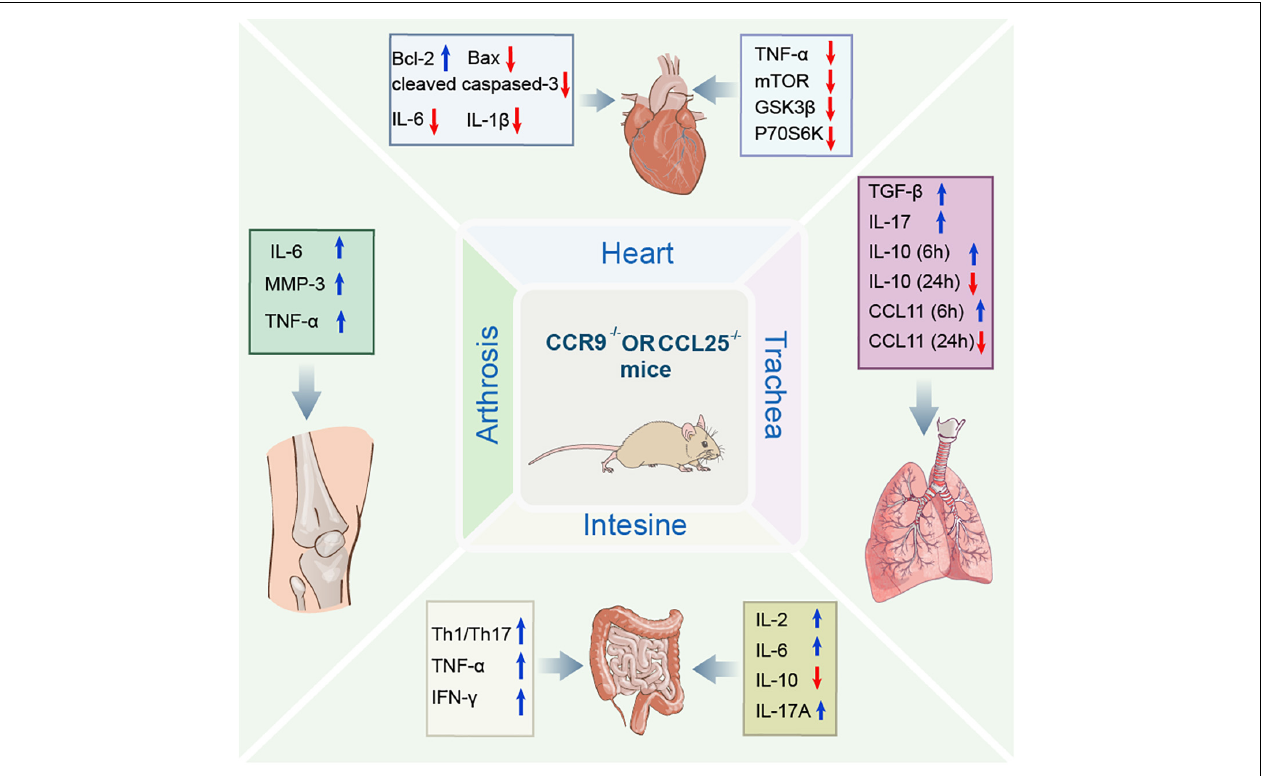
FIGURE 2 | Schematic diagram illustrating the regulation of molecular mechanisms of CCR9/CCL25 in inflammatory diseases. CCR9/CCL25 exerts multiple effects in a variety of inflammatory diseases by regulating molecular mechanisms, such as molecules associated with apoptosis and inflammation. CCR9, C-C chemokine receptor 9; CCL25, C-C chemokine ligand 25; Bcl-2, B-cell lyumphoma-2; Bax, Bcl-2 Associated X-protein; IL-6, interleukin-6; IL-1 β , interleukin-1 β ; TNF- α , tumor necrosis factor- α ; mTOR, mechanistic target of rapamycin; GSK3 β , glycogen synthase kinase 3-beta; p70S6K, p70 S6 kinase; IL-10, interleukin-10; MMP3, matrix metalloproteinase-3; TNF- β , tumor necrosis factor- β ; IL-17, interleukin-17; CCL11, C-C chemokine ligand 11; Th1/Th17, helper T1/helper T17; IFN- γ , interferon-gamma; IL-2, interleukin-2; IL-17A,